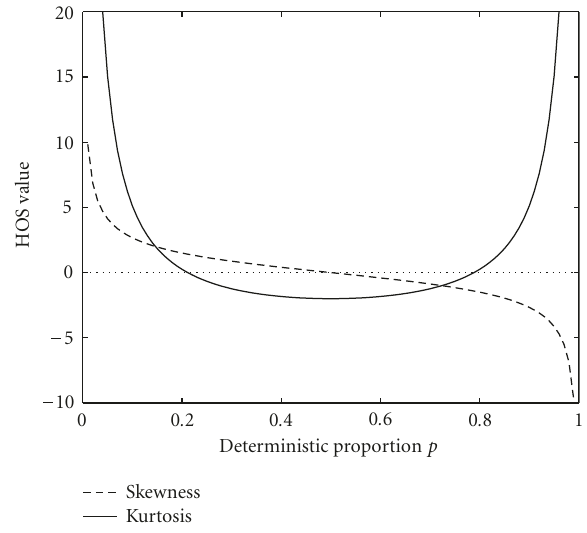
Figure 8: Skewness (dashed line) and kurtosis (solid line) for SNR =